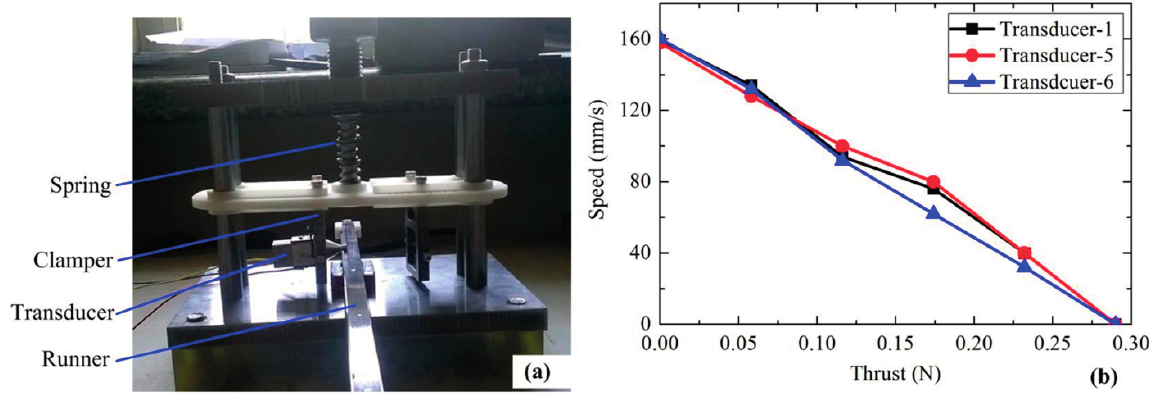
Figure 10. Plot of the thrust force versus the speed of the